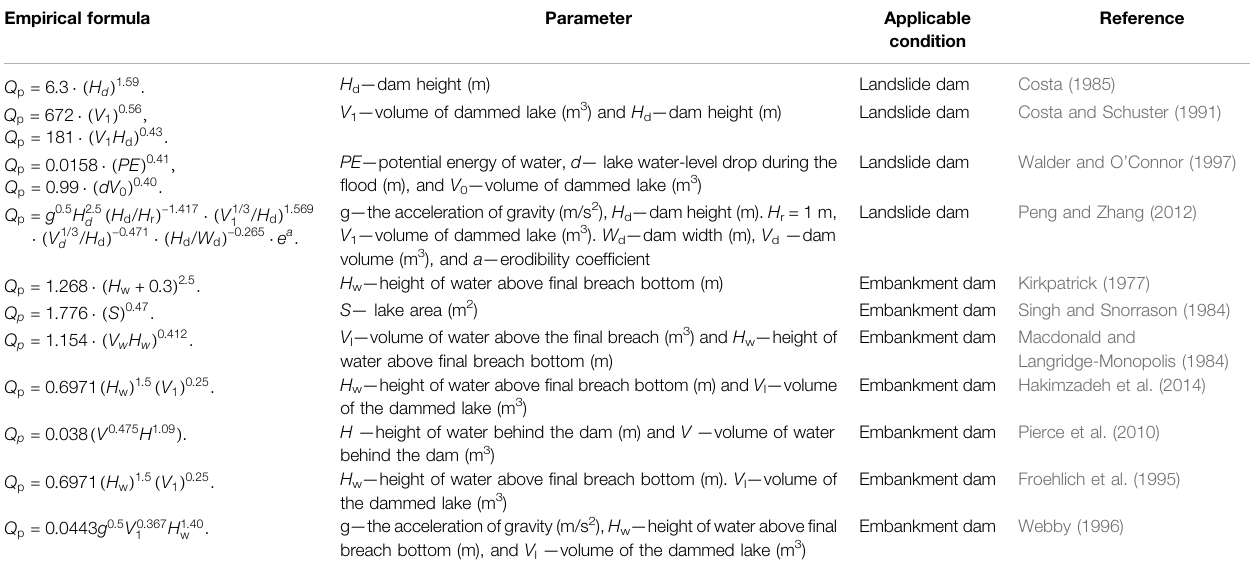
TABLE 6 | Empirical formula for the peak discharge of dam break. Empirical